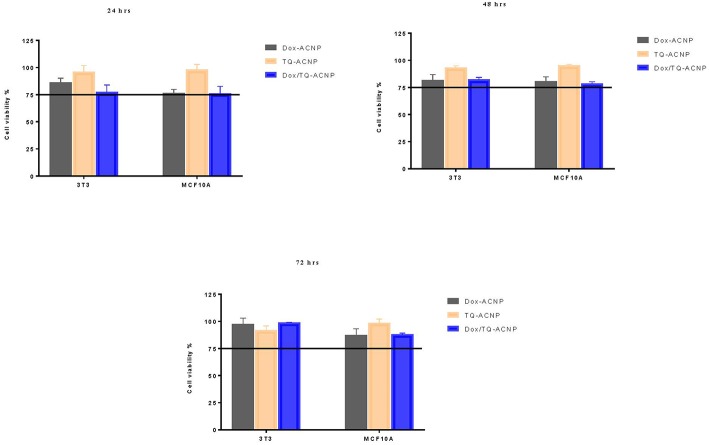
Graphical representation of the percentage viability of 3T3 and MCF10A at IC50 values of MDA MB 231 cells.